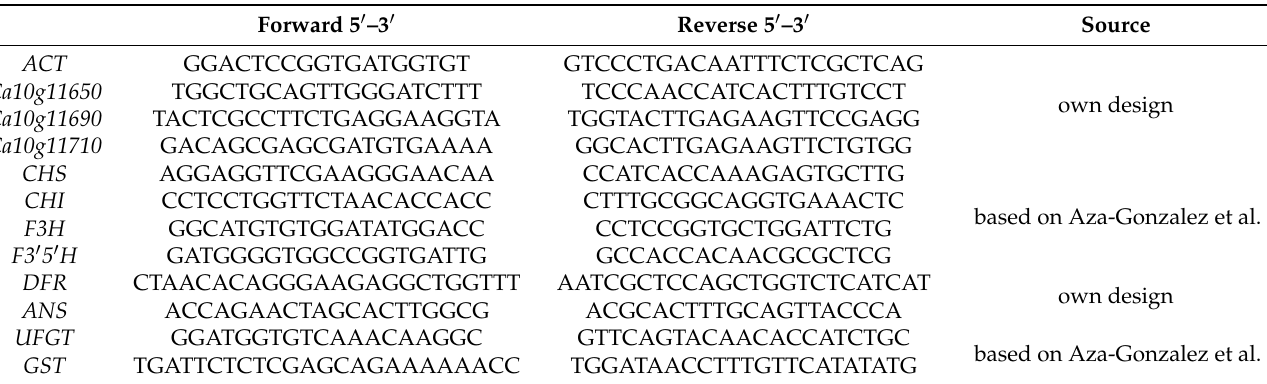
Table 2. Primers used for